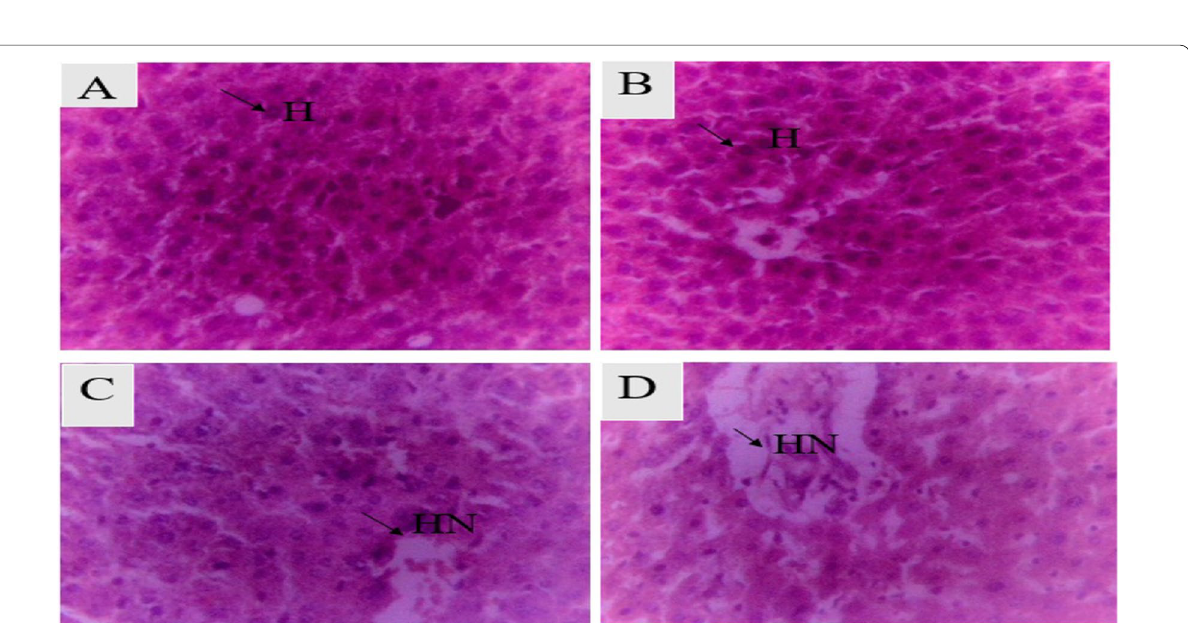
The values were tabulated as mean DW distilled water, CAE Culcasia angolensis leaves extract